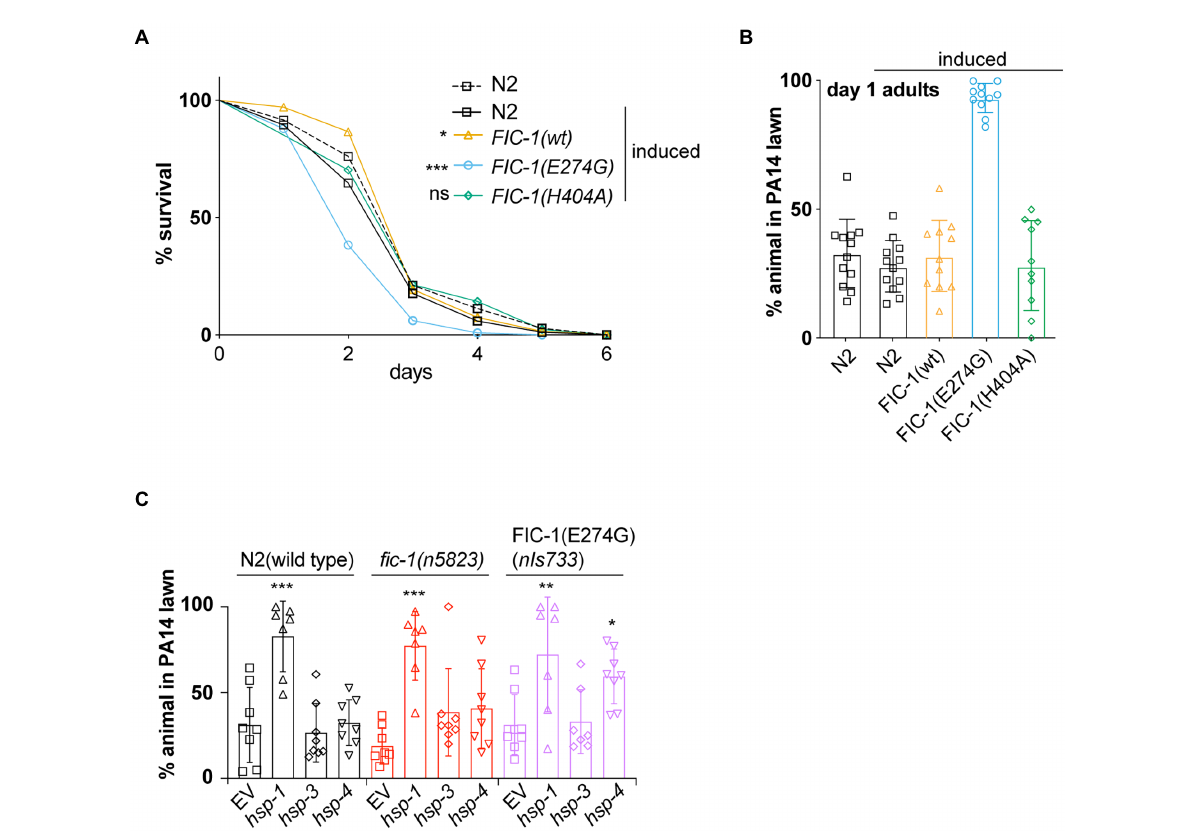
FIGURE 2 FIC-1(E274G)::HA OE inhibits pathogen avoidance behavior in Caenorhabditis elegans . (A) Survival of indicated strains on Pseudomonas aeruginosa PA14 plates. n > 80 animals per condition. Statistical significance was calculated using Gehan-Breslow-Wilcoxon test. (B) Synchronized young adults of indicated strains were placed in the center of a P. aeruginosa PA 14 lawn and incubated for 20 h. Number of worms remaining and leaving P. aeruginosa PA 14 lawn was determined. (C) Synchronized young adults of indicated strains were treated with indicated RNAis for 48 h and subsequently placed in the center of a P. aeruginosa PA 14 lawn and incubated for 20 h. For (B,C) : Each datapoint represents a biological replicate with >20 animals per replicate and condition. Statistical significance was calculated using Kaplan–Meier test (A) , unpaired t -tests comparing induced N2 with induced nIs774 groups (B) and ANOVA test with multiple comparisons, using wild type as reference (C) . * p < 0.05, ** p < 0.01, *** p < 0.001, not significant (ns) p >